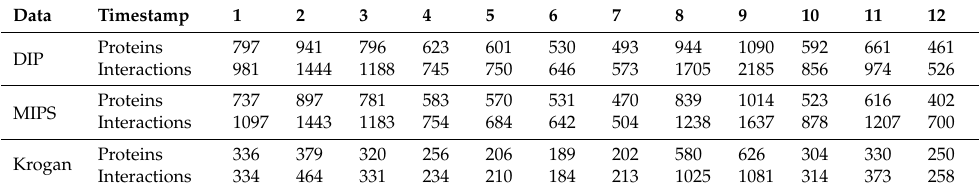
Table 1. The number of proteins and interactions in each subnet of different PPI